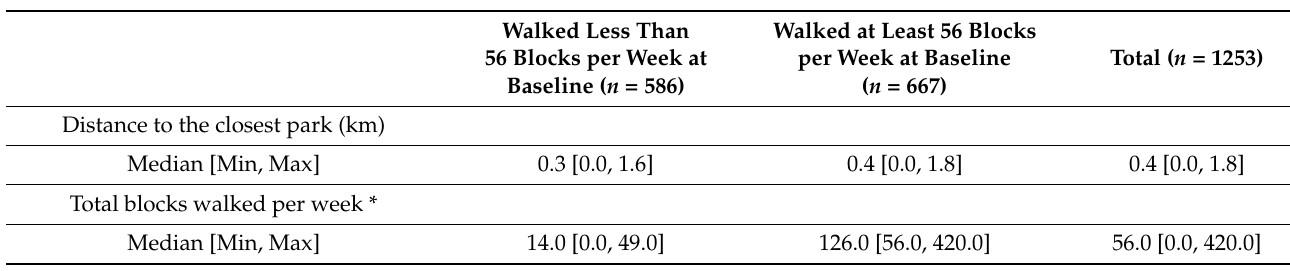
Walked at Least 56 Blocks